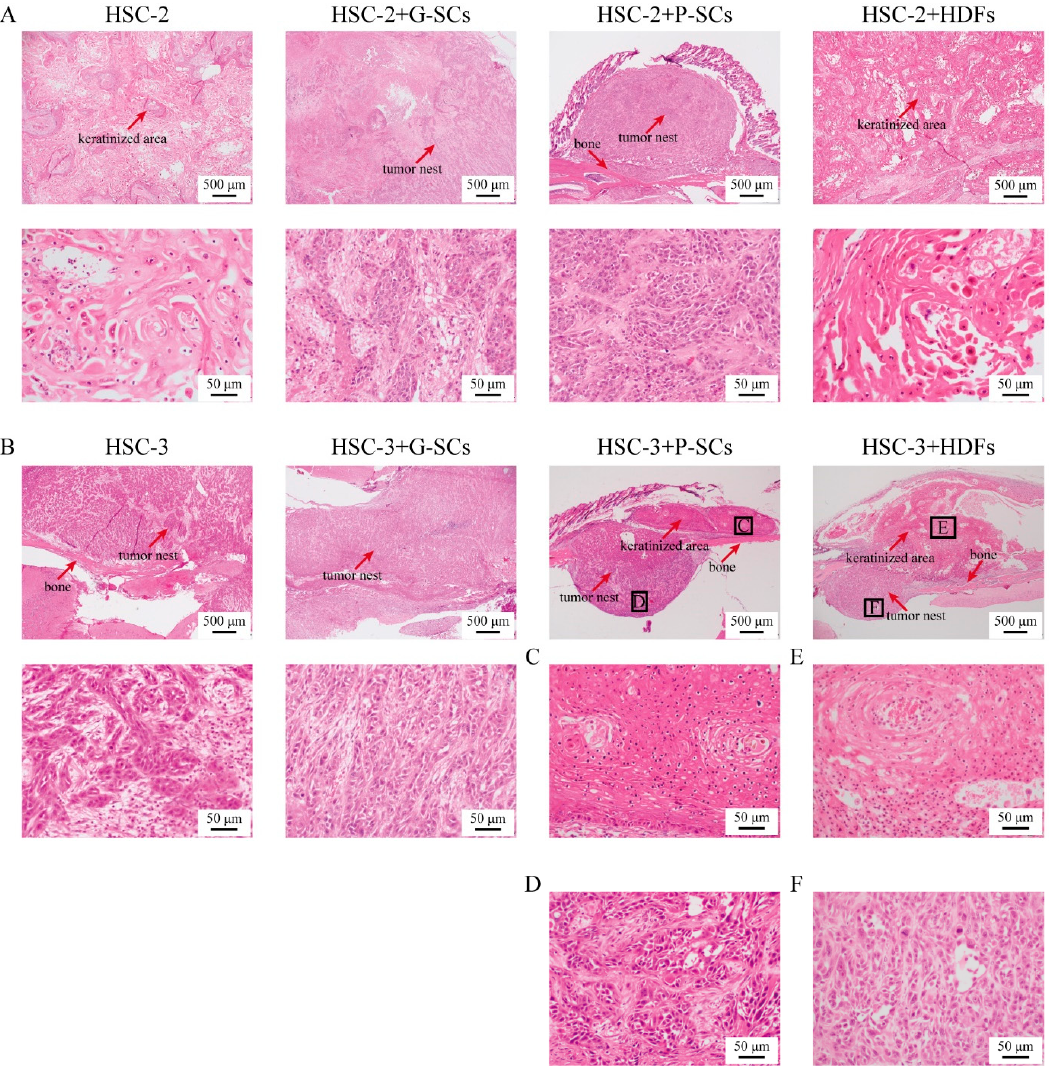
Figure 6. G-SCs and P-SCs inhibited the differentiation of OSCC in vivo. ( A ) The effect of G-SCs and P-SCs on the differentiation of HSC-2 in vivo was examined by HE staining. ( B ) The effect of G-SCs and P-SCs on the differentiation of HSC-3 in vivo was examined by HE staining. ( C ) The keratinized area of HSC-3+P-SCs. ( D ) The invasion area of HSC-3+P-SCs. ( E ) The keratinized area of HSC-3+HDFs. ( F ) The invasion area of HSC-3+HDFs.